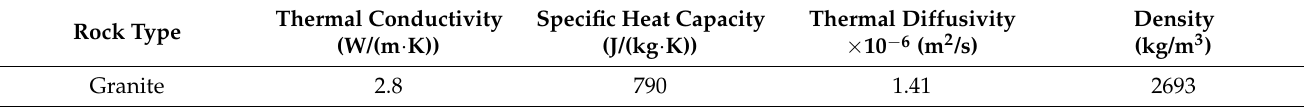
Table 1. Thermophysical parameters of granite.